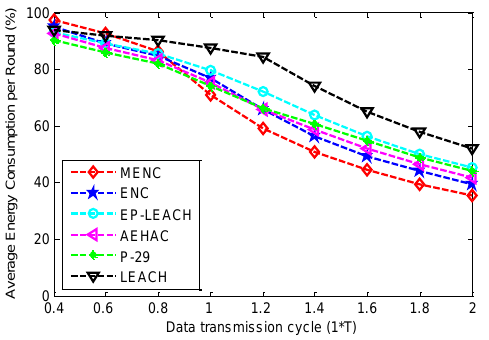
Figure 8. The comparison of AECR among MENC, ENC, EP-LEACH, AEHAC, P-29 and LEACH for different data transmission cycles.